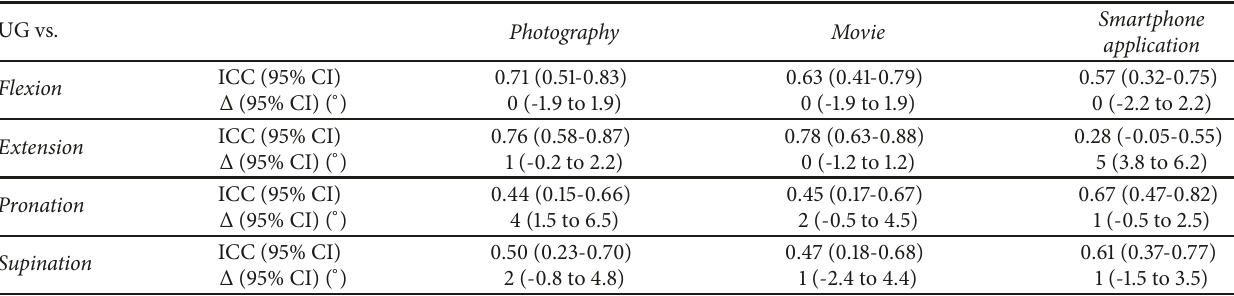
Table 1: Validity of different measurement methods compared to UG measurements (ICC) and mean difference ( (cid:2) ) and 95% confidence intervals (CI) (in